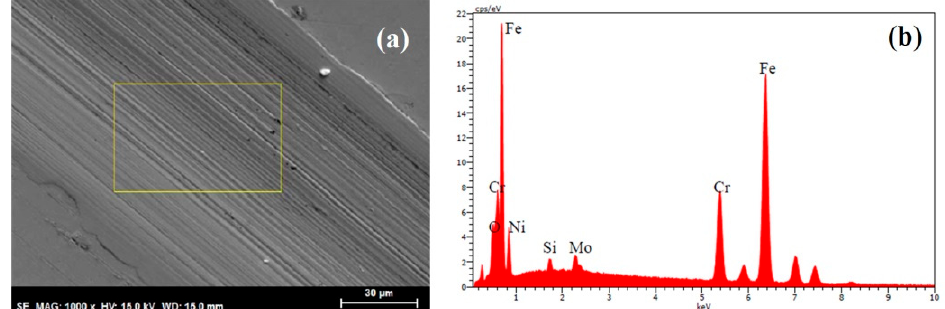
Figure 8. ( a ) SEM micrograph of the wear track on AISI 316L stainless steel disk after lubrication with base oil at 1000 × magnification and ( b ) EDX spectrum of the selected area.